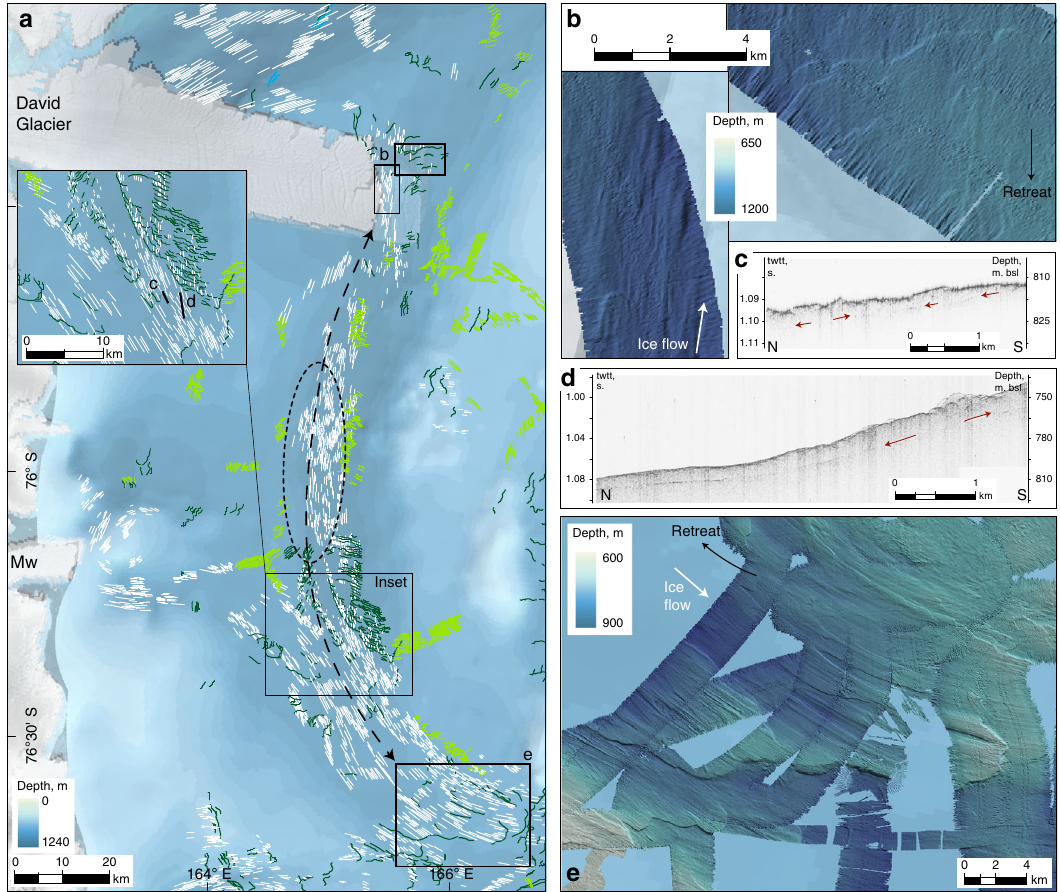
Fig. 3 Flow reversal in southern Drygalski Trough. Background bathymetry from IBCSO 76 ; acoustic data compiled and visualised as described in the 'Methods'. a Mapped lineations (white) form an apparently continuous fl owset south of the Drygalski Ice Tongue. Relationship with grounding line landforms (green) suggests, however, that lineations fl ow northward at the northern end of the group (panel b , white arrow in direction of fl ow), and southward at the southern end (panel e , white arrow in direction of fl ow). c , d Subbottom acoustic pro fi les from NBP1502 show fragments of a buried till horizon, only observed in the southern part of the trough. Increased data coverage from coastal waters (e.g., around 164° E) would greatly